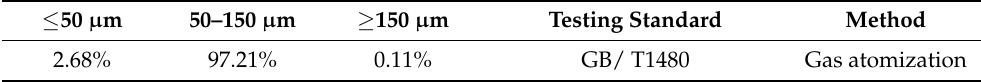
Table 2. Chemical composition of 316L stainless steel powder and G20Mn5QT steel (wt. %).